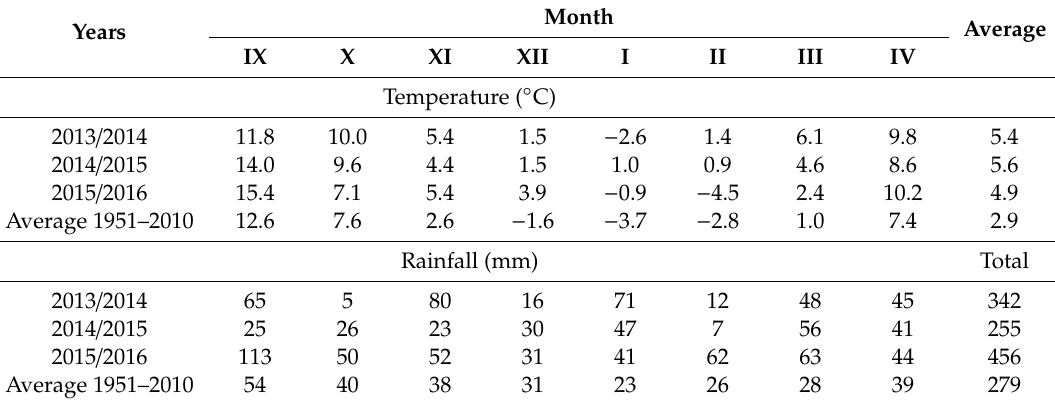
Table 1. Total rainfall and average air temperatures during the experimental trials (2013–2016), as compared to the long-term period (data from the Meteorological Station in Felin, 51.13 o N; 22.37 o